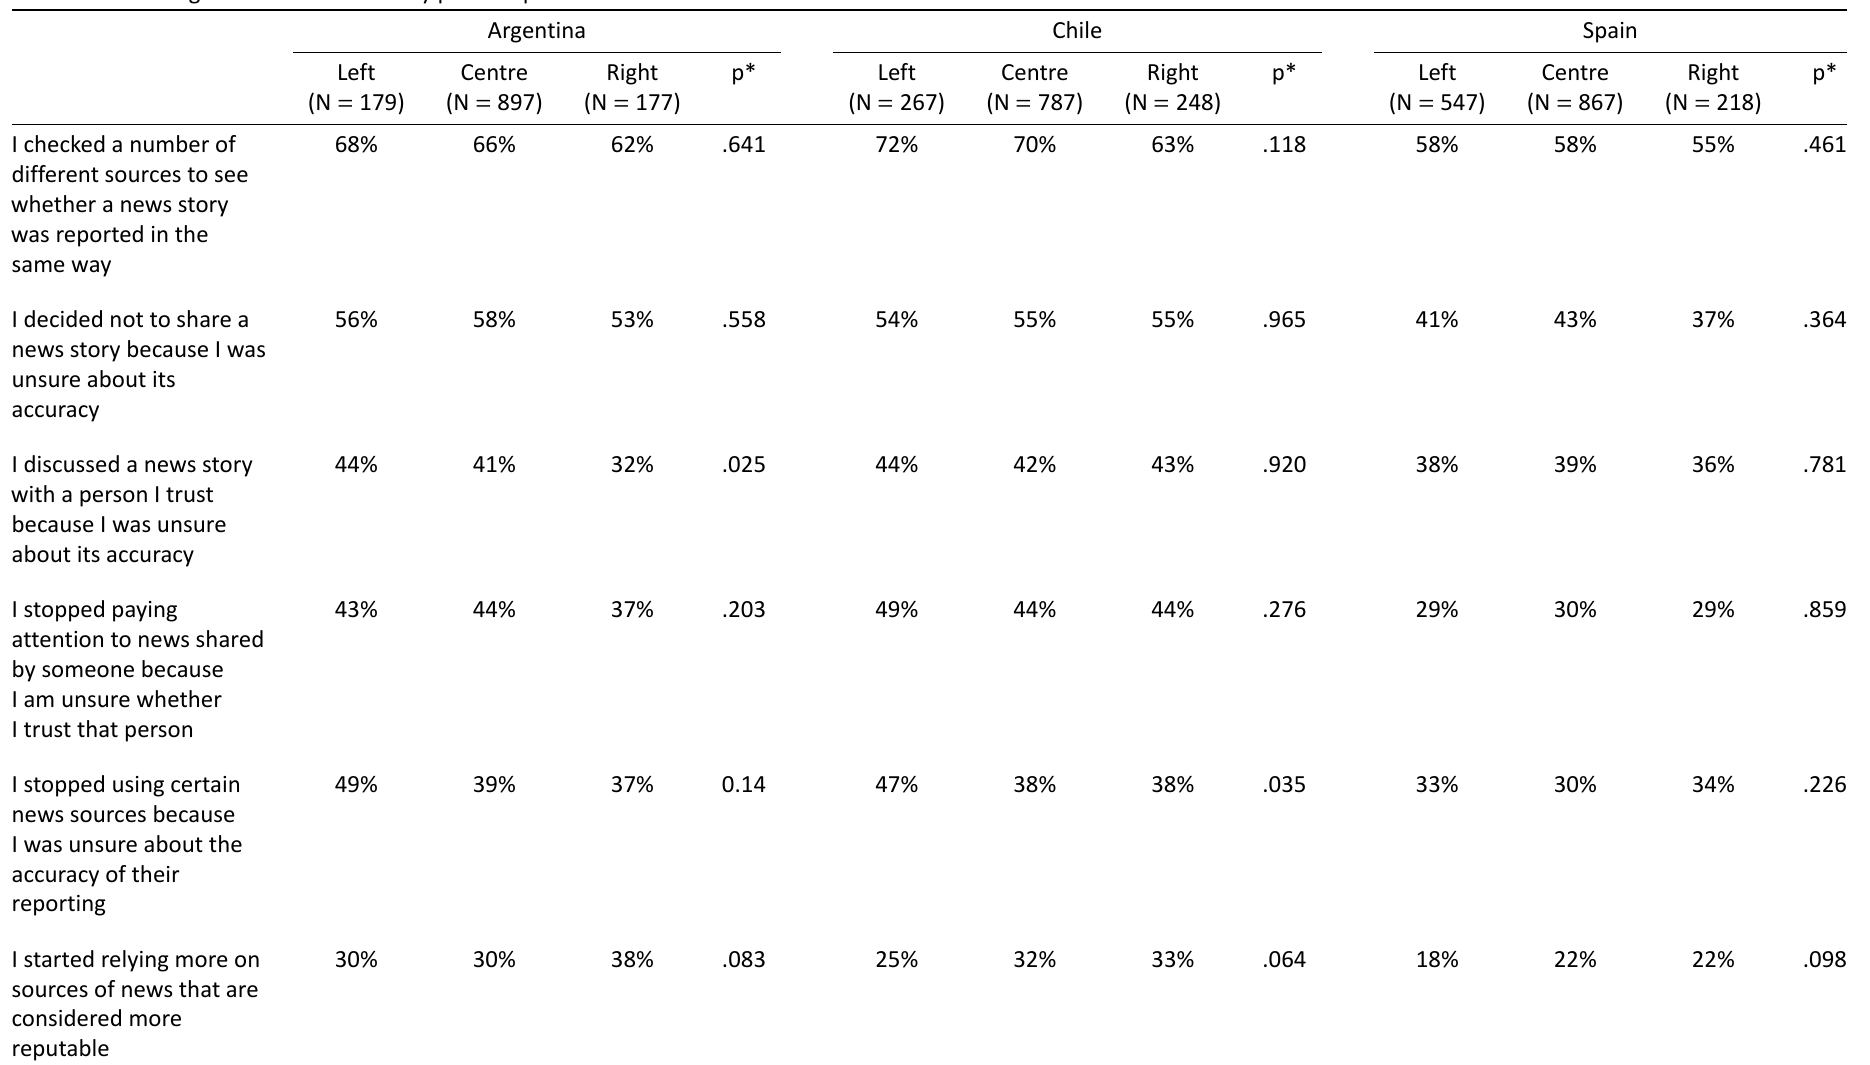
Table 7. Actions against disinformation by political position. Argentina Chile